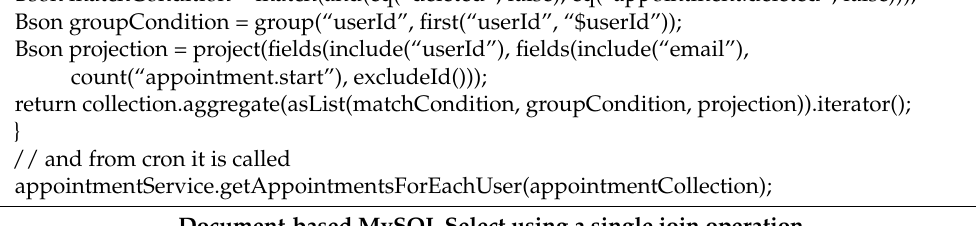
Table 6. Select using a single join operation. MongoDB Select Using a Single Join Operation